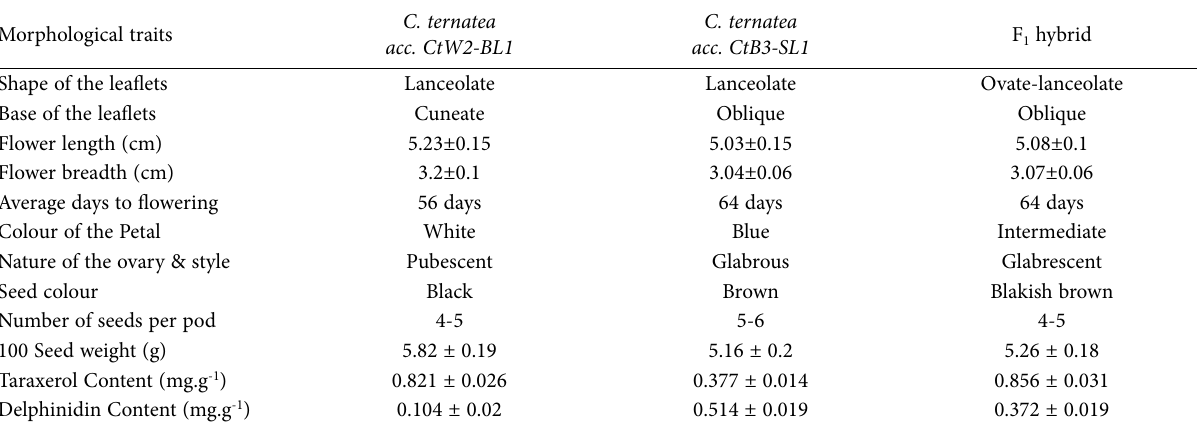
Table 2. Morpho-physiological and metabolite characterization of intra-specific F 1 hybrid of C. ternatea. Morphological traits